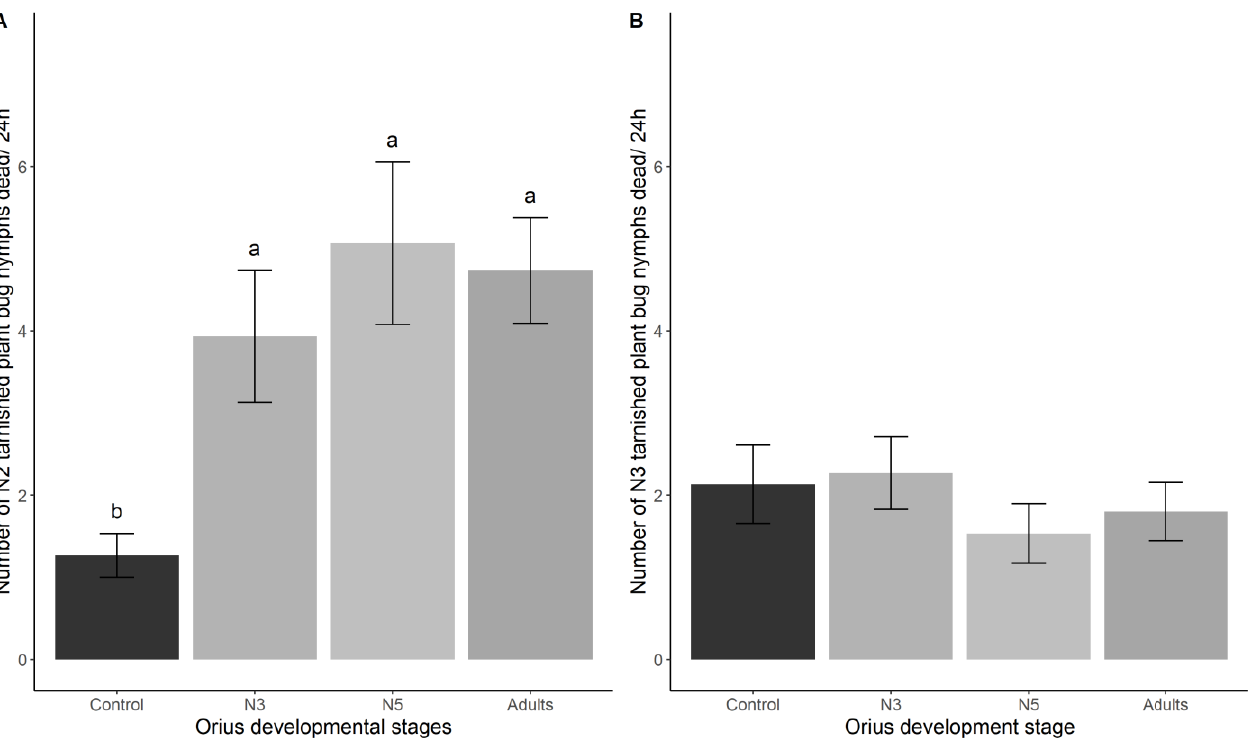
Figure 2. Mean mortality of TPB N2 ( A ) and N3 ( B ) nymphal stages as a function of the Orius insidiosus developmental stage. Error bars represent standard errors. Letters correspond to significant differences among treatments (α = 0.05).